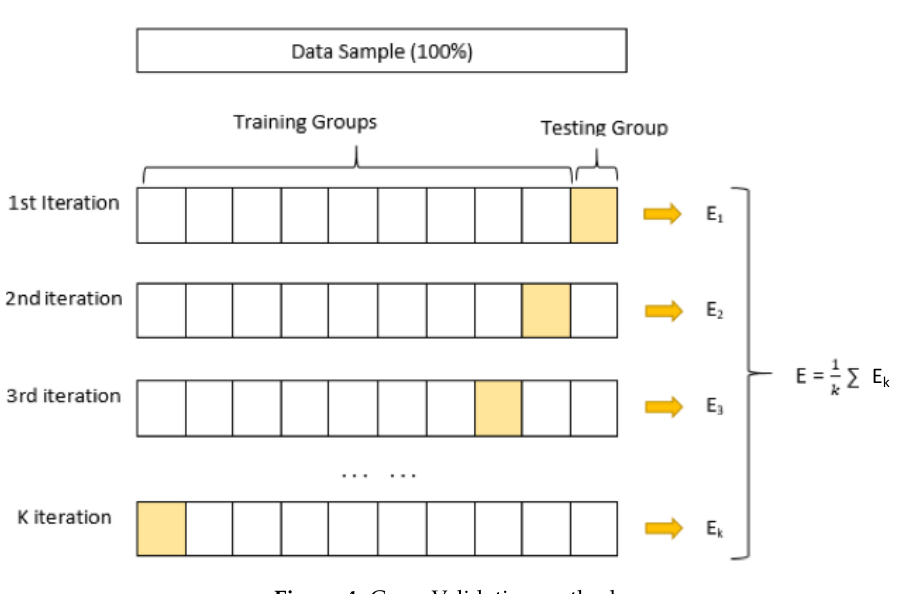
Figure 4. Cross Validation method.